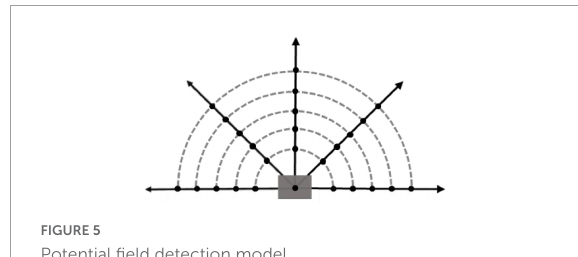
FIGURE5 Potential field detection